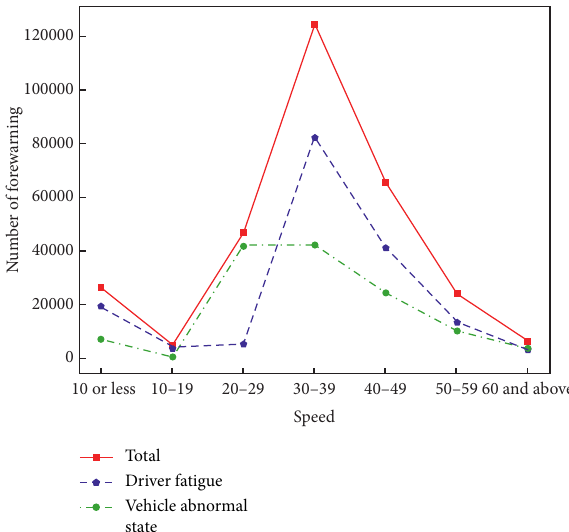
Figure 8: Distribution of forewarning types corresponding to different speeds.